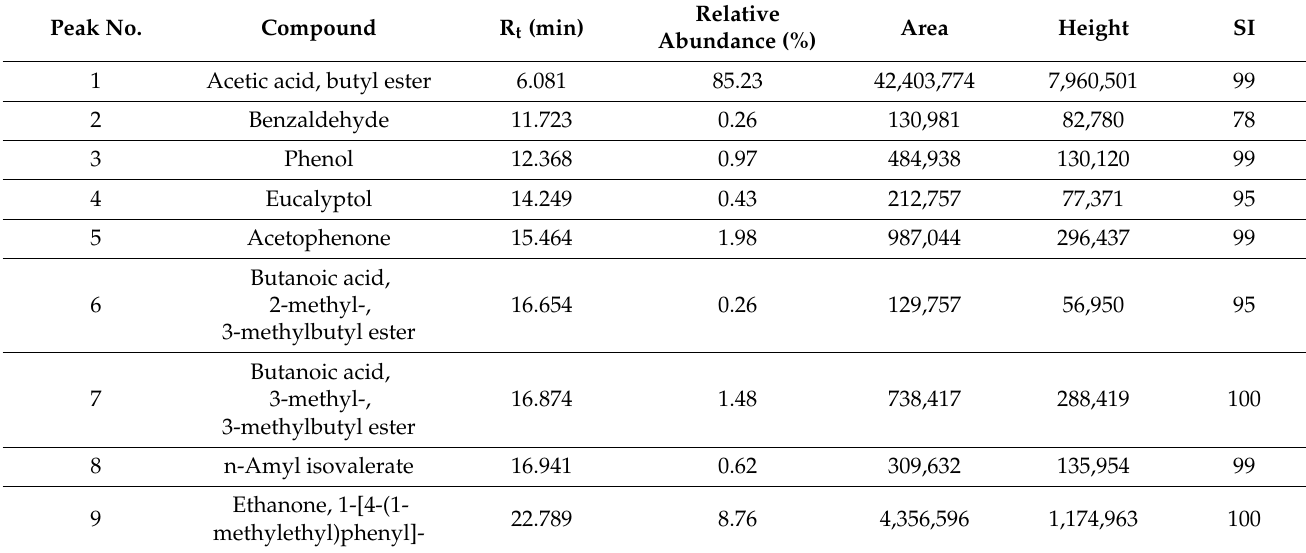
Table 2. Tentative identification and relative quantification of volatile compounds in the methanolic extract of S. bulbocastanum leaves. R t —retention time; Relative abundance—relative percentage (%) of total peaks area. SI—similarity in comparison with NIST27 and NIST147 mass spectra libraries.